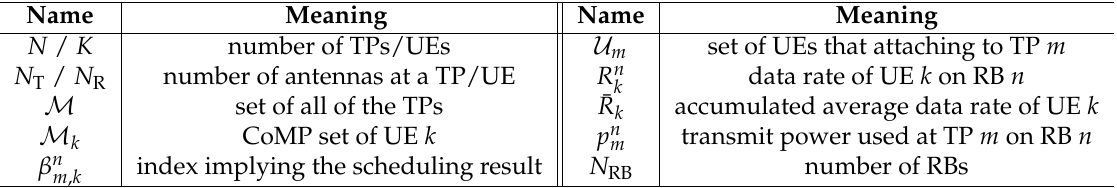
Table 1. Major notations. TP, transmit point; UE, user element; RB, resource